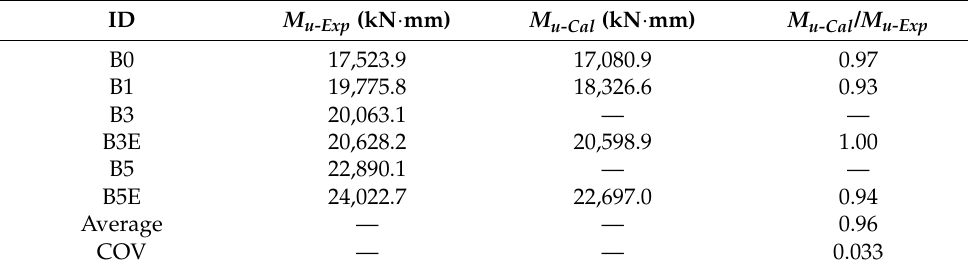
Table 2. Comparison between the experimental and calculated moment capacity